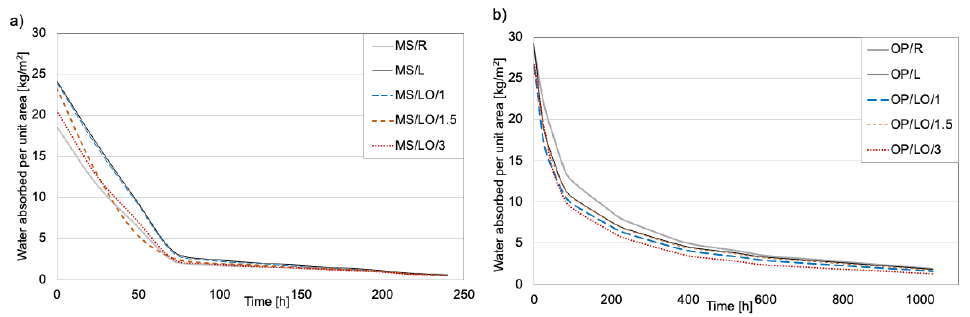
water frequently freezes during winter, due to its long-term use as a de-icing agent. A sodium chloride solution with a concentration required to introduce 1 wt.% of salt in each drying rate values calculated from the curves are given in Table 3. The alterations observed the end of the test are shown in Figures 5 and 6. At the end of the test, the salt efflorescence and debris formed during drying were brushed from the exposed surface, and its weight was measured. To distinguish the mass of salt from that of debris (paint layer and stone), the brushed material was diluted in ca. 100 mL of pure water, then filtered, and the mass of insoluble material was determined after drying to a constant mass at 60 ◦ C. Figure 7 shows the mass of salt and debris registered for each